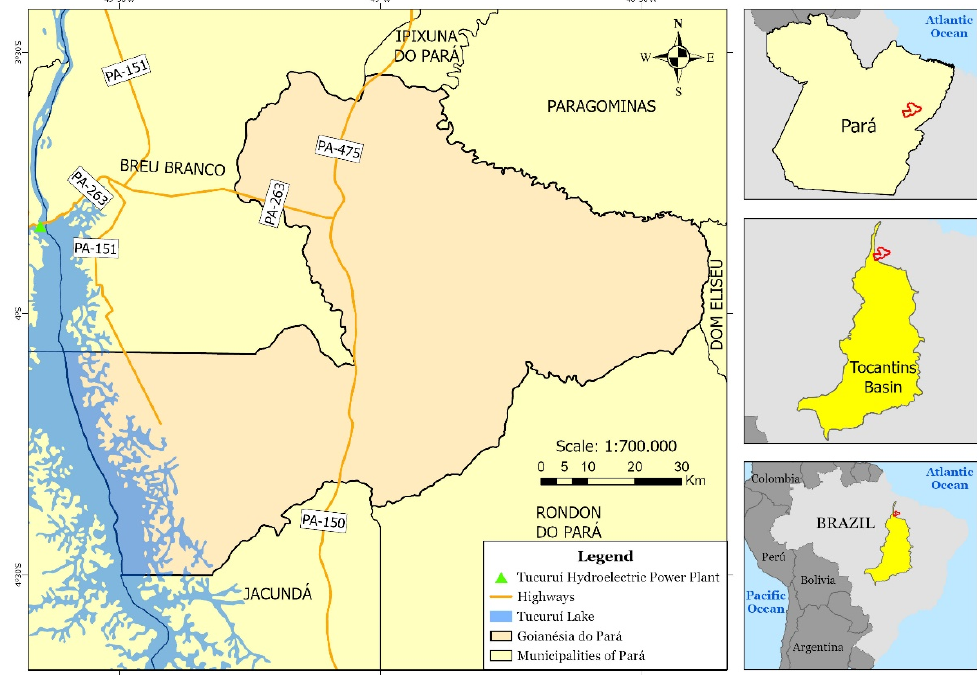
Figure 1. Location of the study area: municipality of Goianésia do Pará.